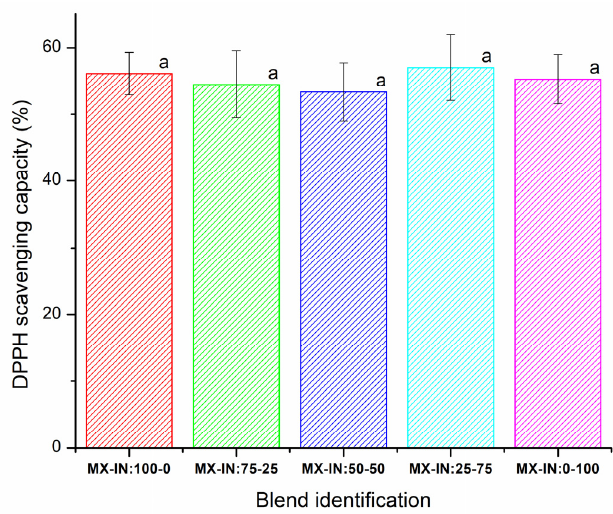
Figure 1. Antioxidant activity of the functional food in all the range of MX-IN concentrations. The lowercase letters indicate mean differences at 0.05 of significance value.